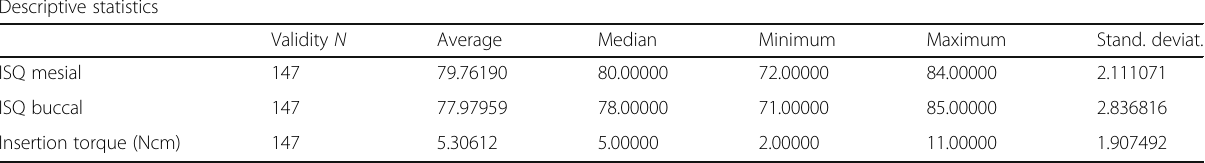
Table 1: Parameters for continuous variables: ISQ mesial, ISQ buccal and insertion torque. Descriptive statistics